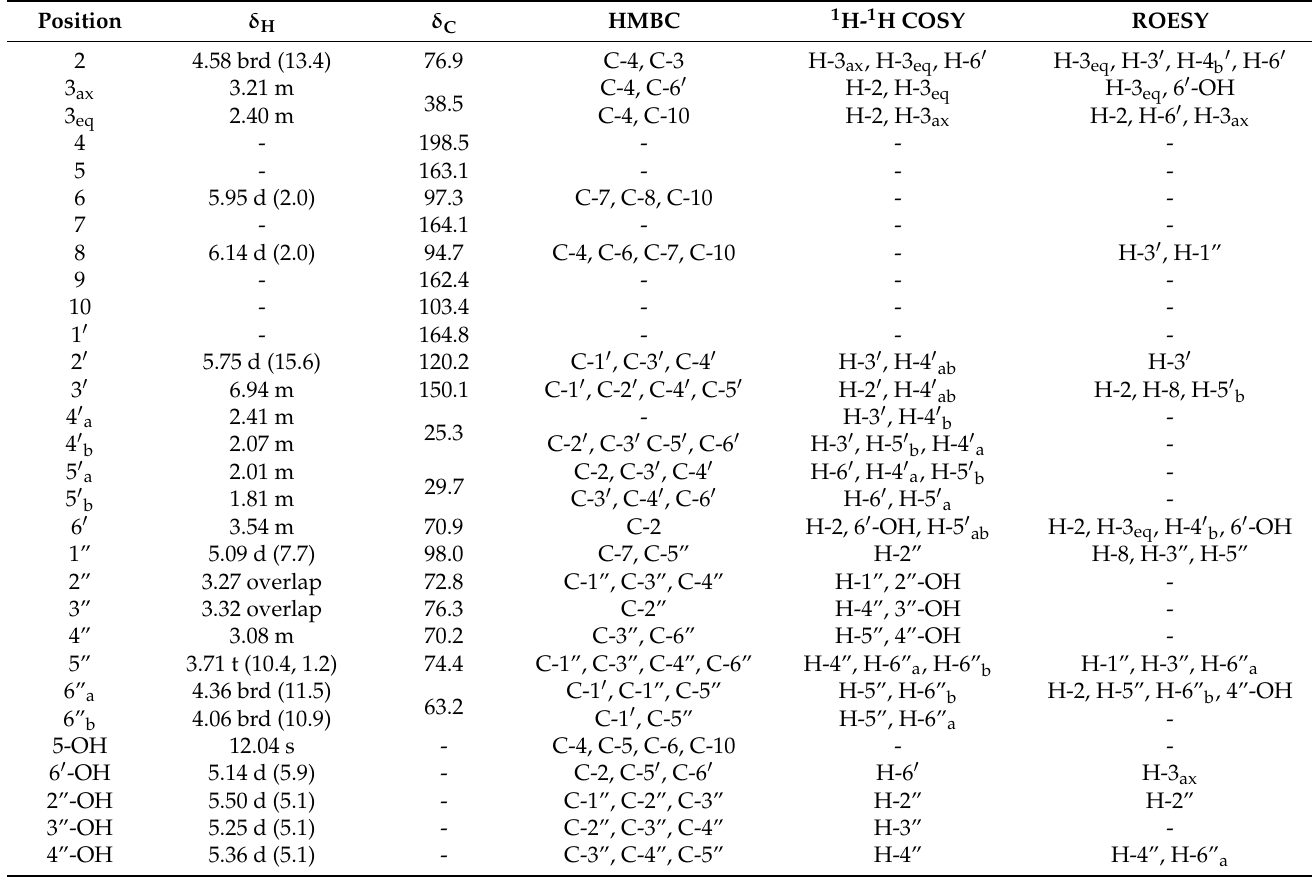
Table 1. 1D and 2D NMR (500 MHz) data of moniristenulide ( 1 ) in DMSO- d 6 ( δ in ppm, J in